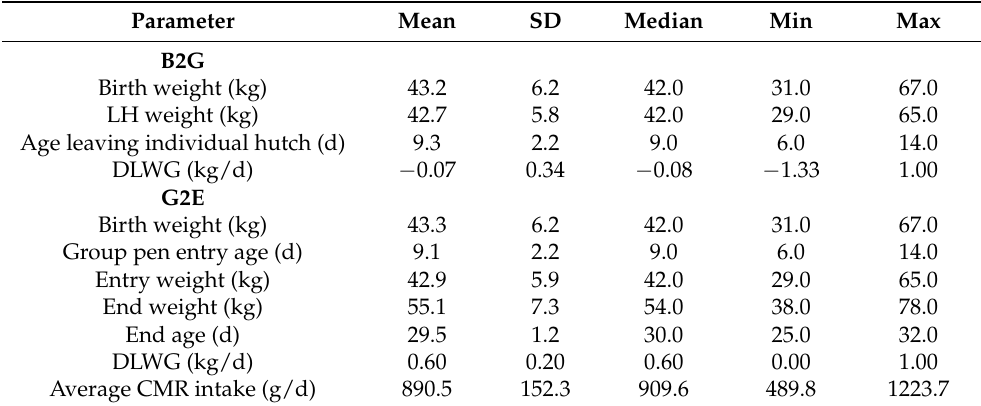
Table 3. Description of calf-related parameters by phase: individually housed in hutches (B2G), and whilst housed in group housing igloo pens